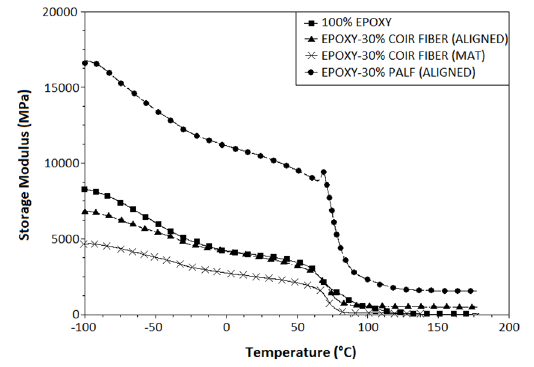
Figure 2. The variation of storage modulus as a function of temperature for the different